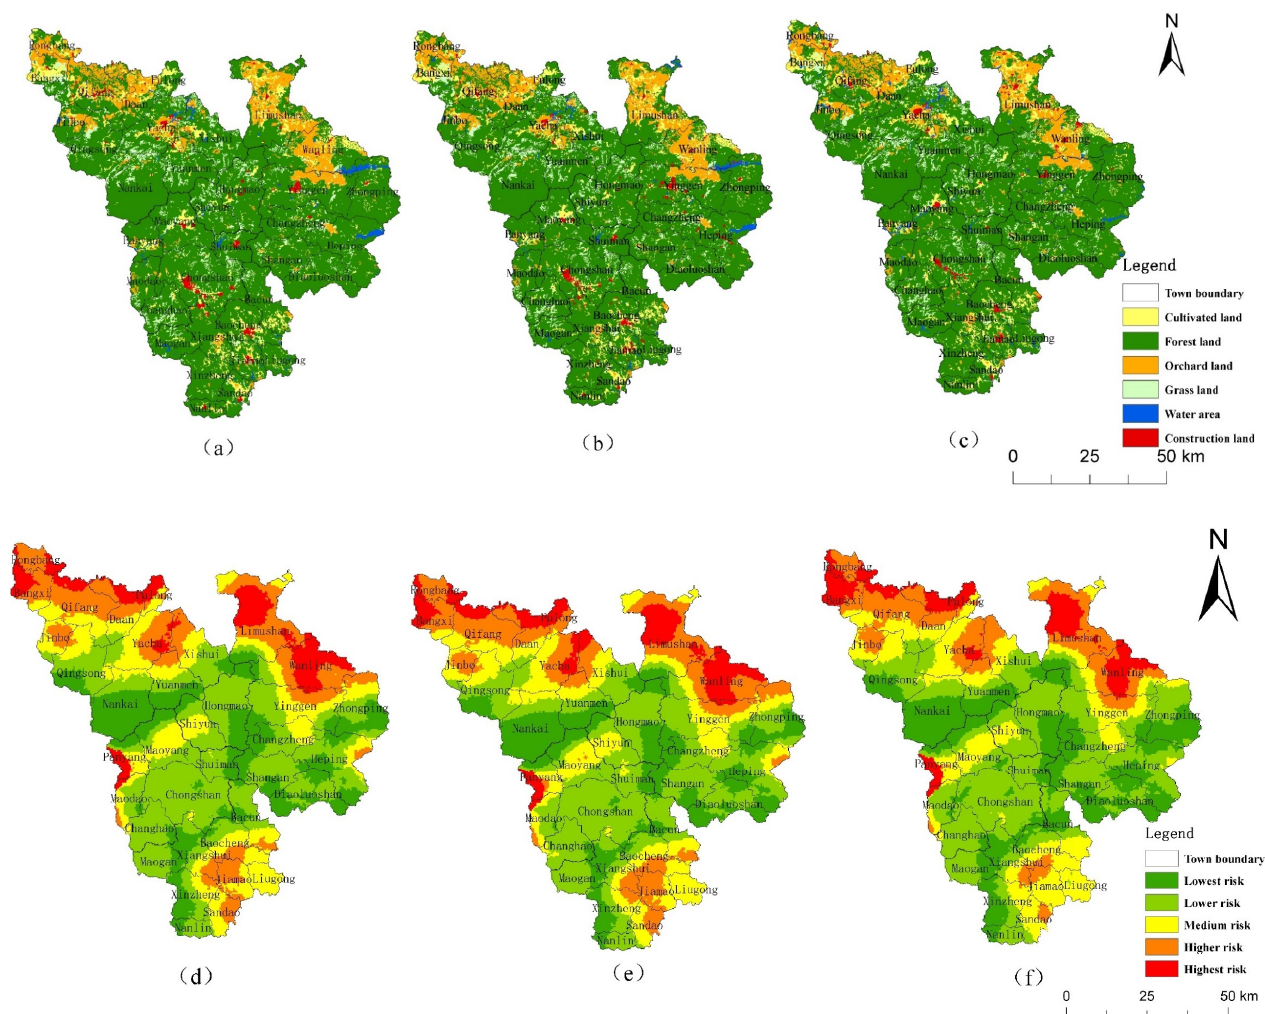
Figure 6. Multi-scenario simulation of land-use ( a ) NDS, ( b ) EDS, and ( c ) EPS, and landscape ecological risk ( d ) NDS, ( e ) EDS, and ( f ) EPS in 2026.